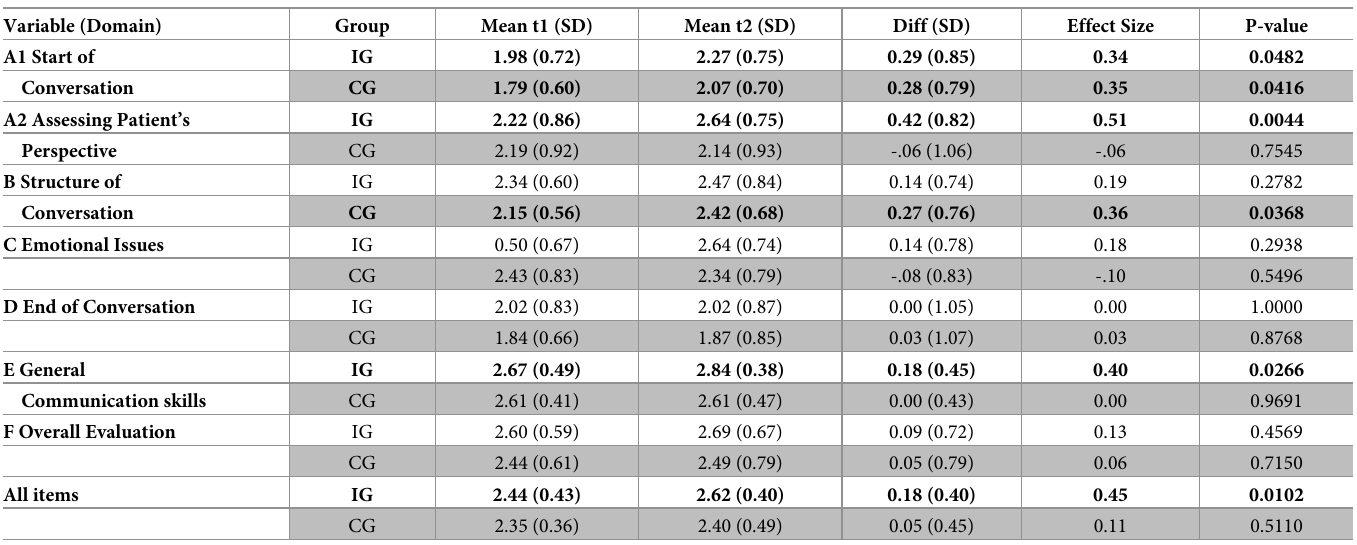
Table 7. Effect of the coaching on the